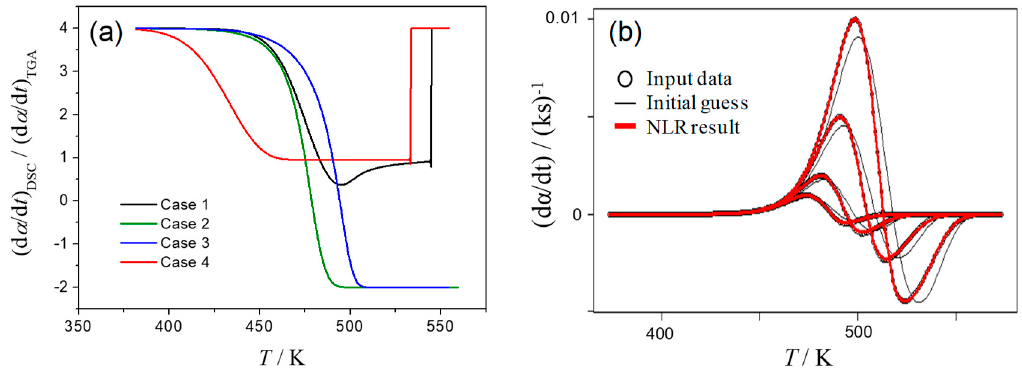
Figure 5. Kinetic deconvolution analysis: ( a ) Ratio of the conversion rates from DSC to DTG dependences on temperature for cases 1–4 at β = 2 K min − 1 , ( b ) Fit of DSC data for Case 3 under various heating rates (points) with Equation (8) with optimized parameters (thick red line).